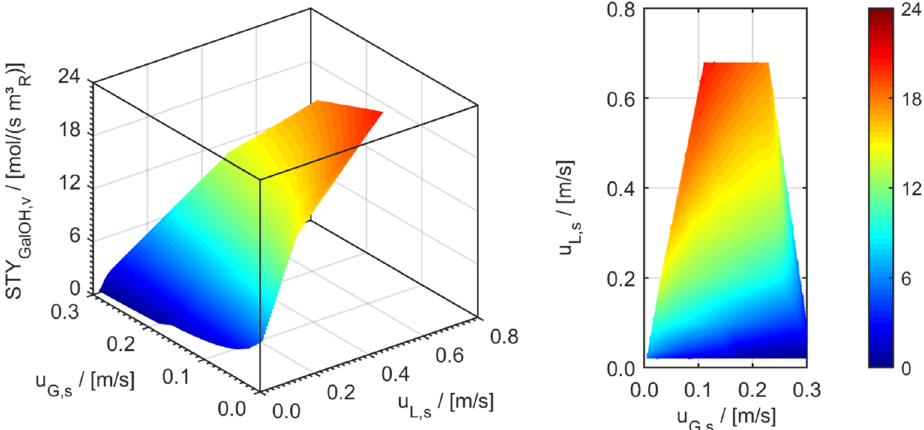
Figure 6. Volumetric space-time yield referring to galactitol in minichannel wall reactors operating in the Taylor flow mode of different gas and liquid superficial velocities.